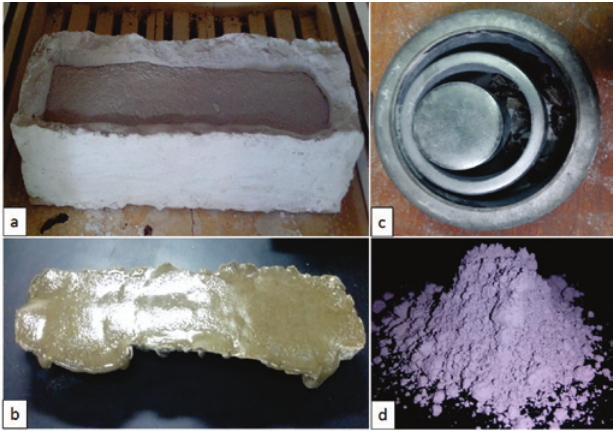
(a) Recipiente de gesso contendo RBRO antes do tratamento térmico, (b) RBRO após tratamento térmico, (c) Moinho de argolas, (d) Resíduo tratado termicamente após o processo de